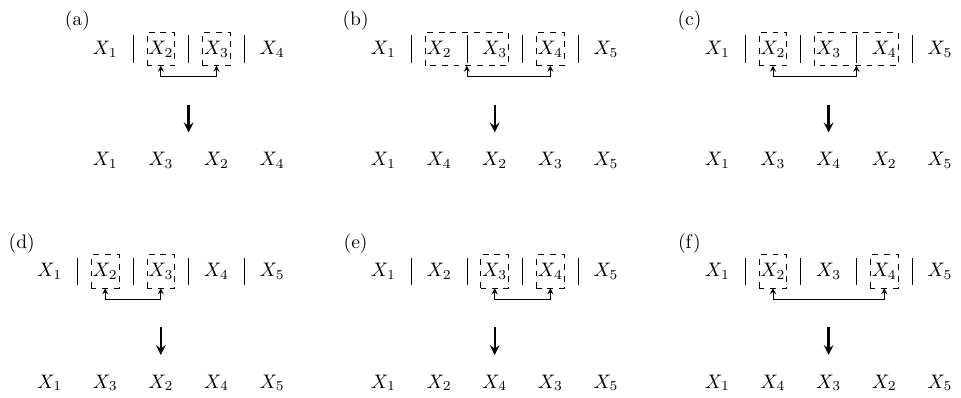
Figure 2. Relationship between classical rearrangements and k -cut rearrangements. Cuts are rep- resented by vertical lines, while dashed rectangles define blocks that are moved in classical rear- rangements. ( a ) when k = 3, a k -cut rearrangement corresponds to a transposition (here of blocks X 2 and X 3 ). ( b – f ) are the 5 possible cases that we can get with a 4-cut rearrangement, all of them corresponding to a block interchange of dashed